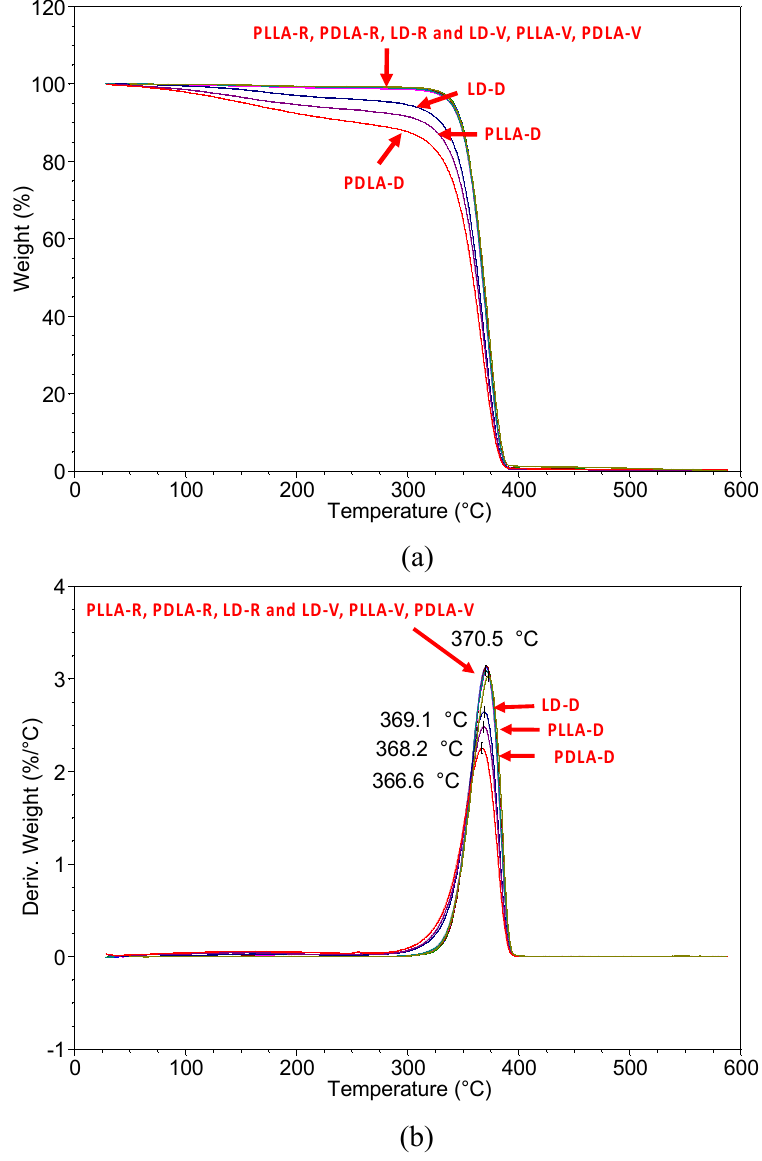
Figure 1. ( a ) Thermogravimetric analysis (TGA) and ( b ) derivative thermal gravimetric (DTG) curves of poly(L-lactide) (PLLA), poly(D-lactide) (PDLA), and the PLLA/PDLA (LD) blend at a heating rate of 10 °C/min.